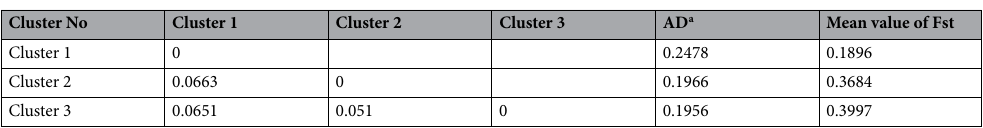
Table 6. Allele-freq. divergence among pops (Net nucleotide distance), computed using point estimates of P through structure analysis. a Average distances (expected heterozygosity) between individuals in same cluster.